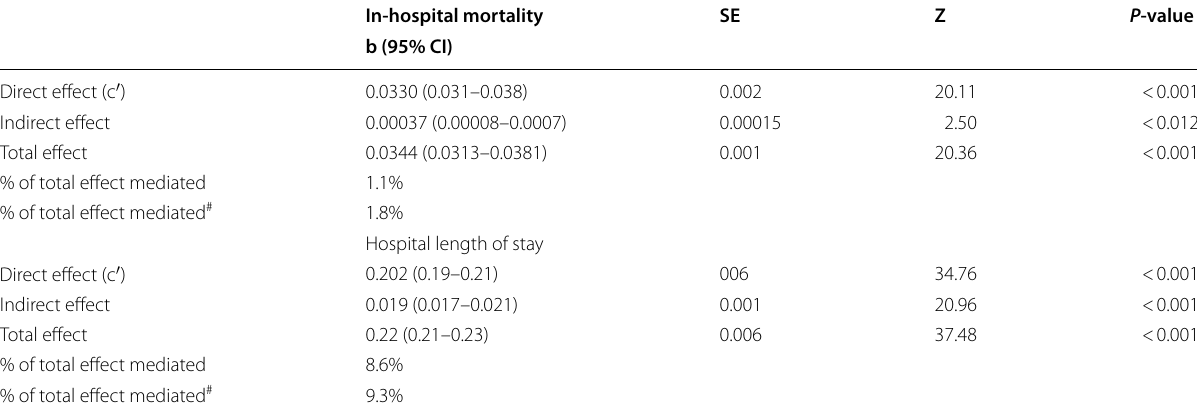
Adjusted for Australian and New Zealand Risk of Death (ANZROD). ANZROD is derived from patient and clinical characteristics, including the Acute Physiology and Chronic Health Evaluation (APACHE) III, ICU admission source, admission diagnoses, Acute Physiology score (APS), APACHE III chronic health score, treatment limitation, and ventilation status # Analysis adjusted for age and sex